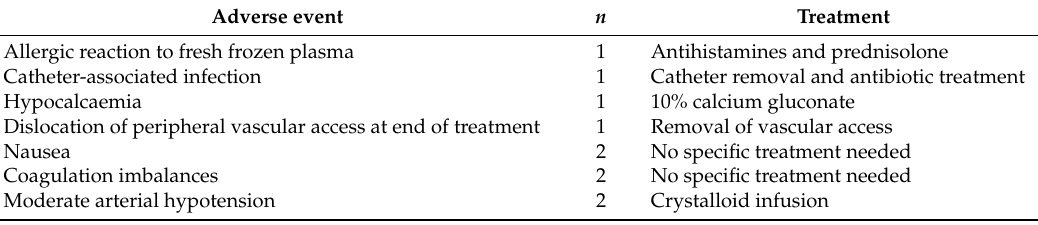
Table 4. Complications of TPE in GCS-unresponsive CIS and MS patients during treatment of relapse A. Adverse